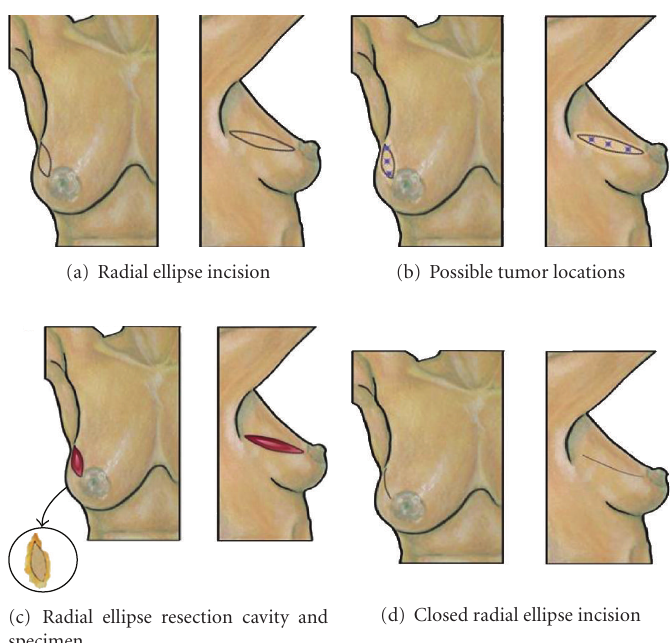
Figure 2: Radial ellipse segmentectomy. (a) Shows location of radial ellipse segmentectomy skin incision in upper outer quadrant. (b) Shows multiple “stars” indicating possible tumor locations suitable for this approach. (c) Shows resection cavity following excision of malignancy with excised specimen (inset). (d) Shows breast following closure of the skin incision.